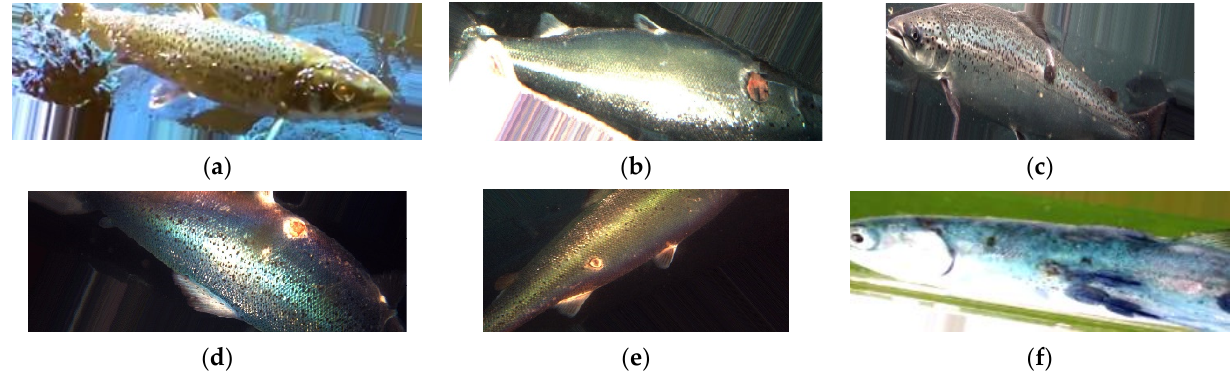
Figure 3. ( a – f ) I mages from the dataset of salmon affected by lice and wounds under different illu- mination